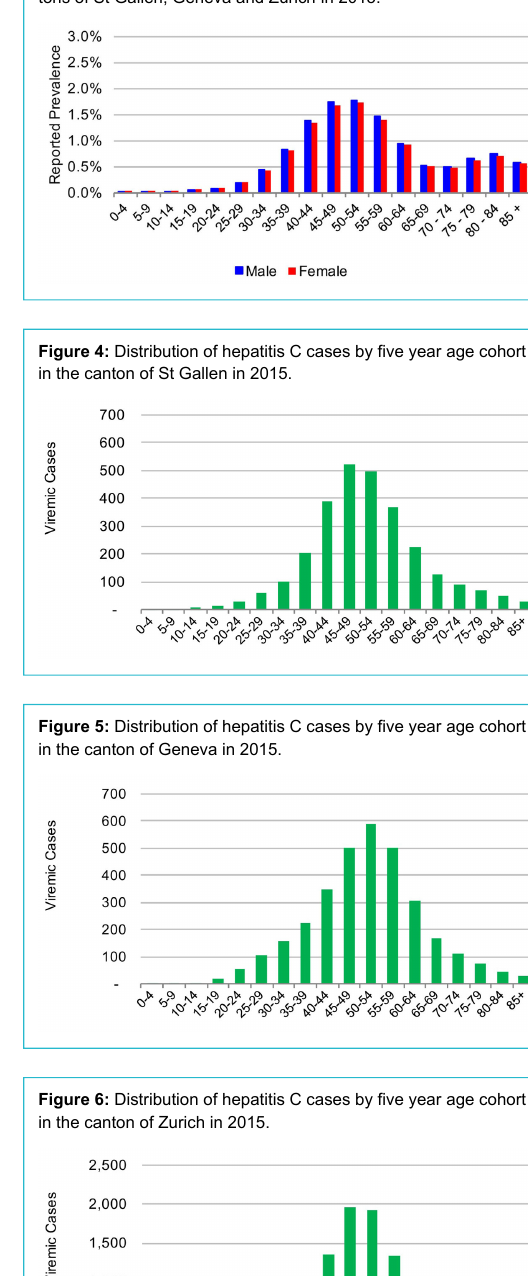
Figure 3: Age and sex distribution of hepatitis C cases in the can- tons of St Gallen, Geneva and Zurich in 2015.